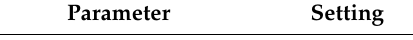
Table 4. I-TLBO Parameter Settings.